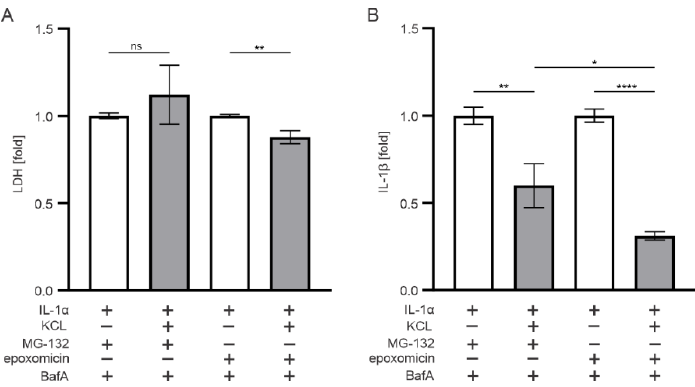
Figure 6. The effect of extracellular KCl on ( A ) cell viability and ( B ) IL-1 β release in ARPE-19 cells upon exposure to epoxomicin or MG-132 and BafA. Data of LDH and IL-1 β were combined from three independent experiments, with four parallel samples in each group. The results are presented as mean ± SEM. * p ≤ 0.05, ** p ≤ 0.01, **** p ≤ 0.0001; ns, not